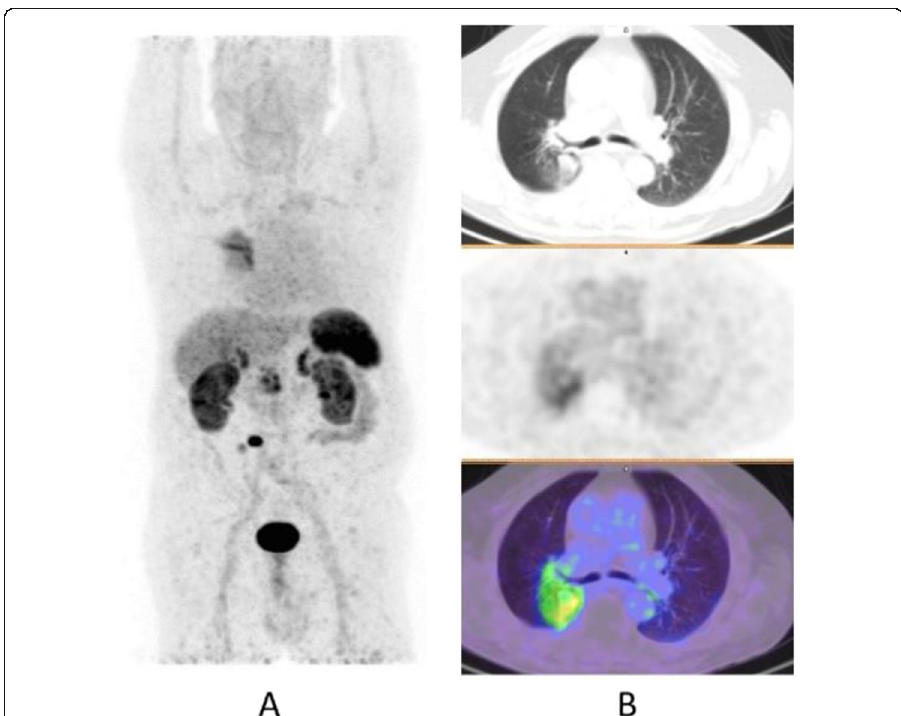
Fig. 58 68 Ga-DOTA peptide, follow-up of midgut NET, specificity. Clinical history : 69 y.o. woman with NET treated by surgery the year before. Right upper lobe lung adenocarcinoma treated by chemo- and radiation therapy 4 years prior. PET/CT findings : in addition to multifocal recurrent disease ( a MIP), 68 Ga-DOTANOC PET shows moderately increased uptake in the previously irradiated lung parenchyma ( b )